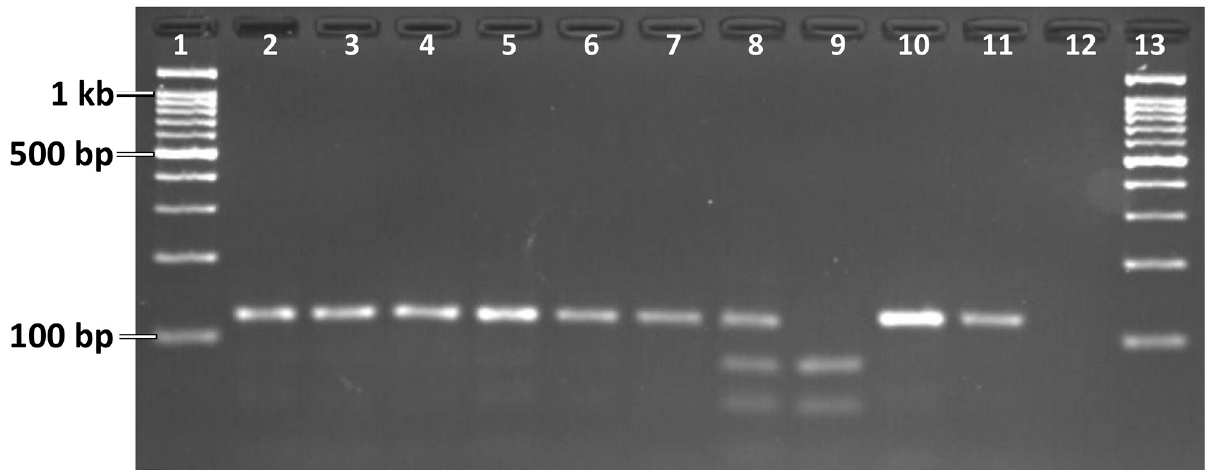
Fig 3. PIRA-PCR assay for kdr genotyping: Gel photograph showing undigested PCR products amplified from individuals belonging to Form A (lanes 2–4) and B (lanes 5–6), and Apo I-digested PCR products from individuals belonging to Form A (lanes 7–9) and B (lanes 10–12). Lane 7: LL, lane 8: LF, lane 9: FF; lane 10–11: LL; Lane 12: negative control without DNA; Lanes 1 & 13: 100 bp ladder.